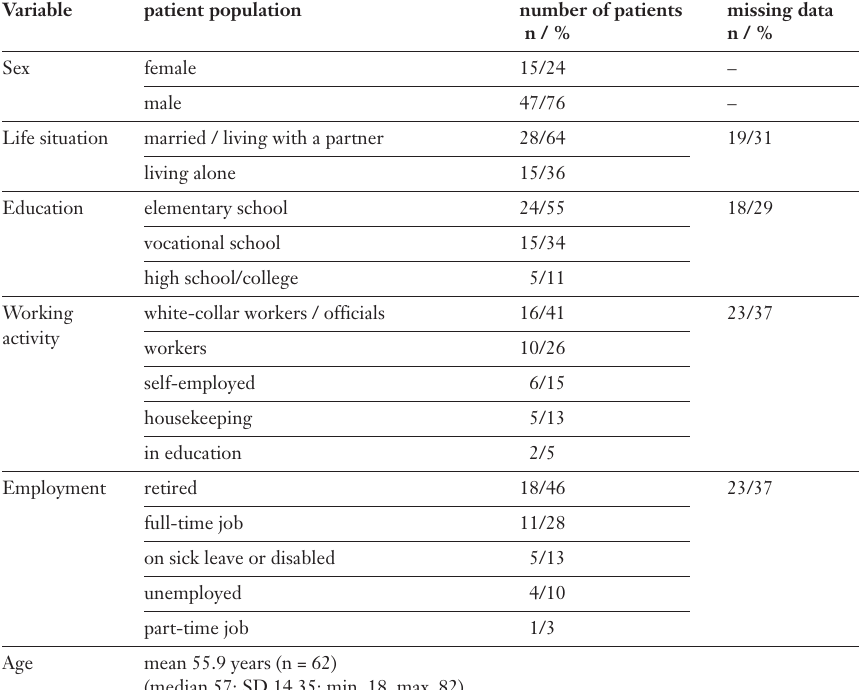
Sociodemographic description of the patient population (n =